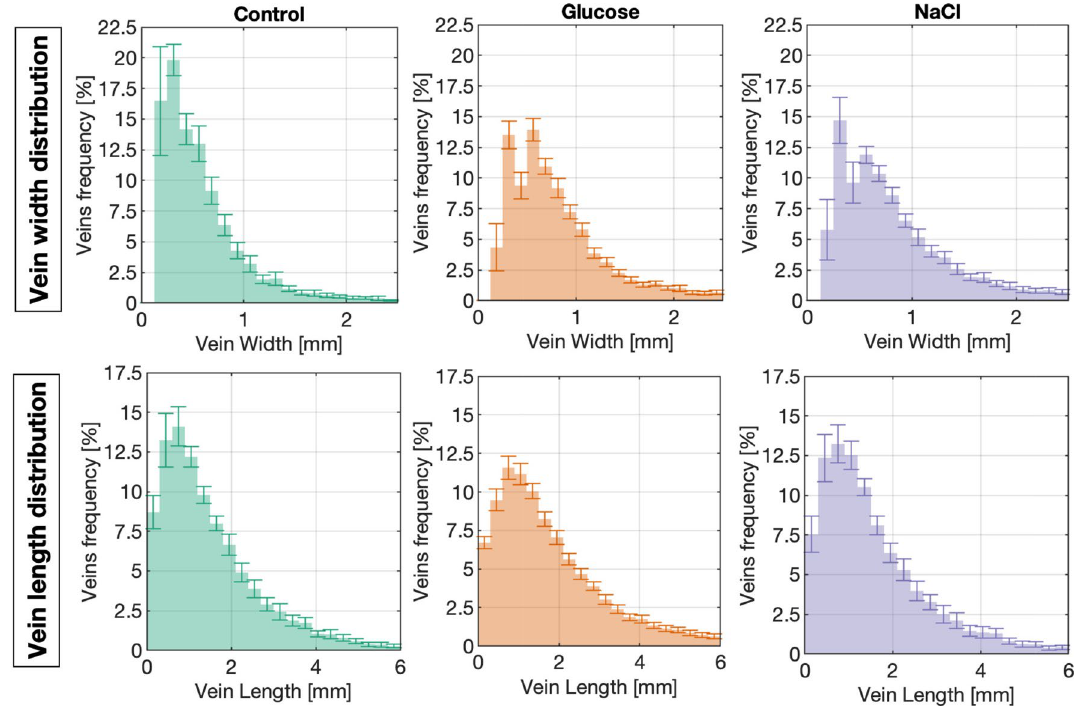
Figure 8. Distribution of veins width (top row) and length (bottom row). Bars in the frequency histograms show the mean percentage of network veins within a given range, while vertical error bars show the confidence interval.